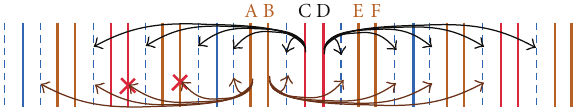
Figure 15: Coulomb transitions of nearest electron pairs at ν = 7 / 11.